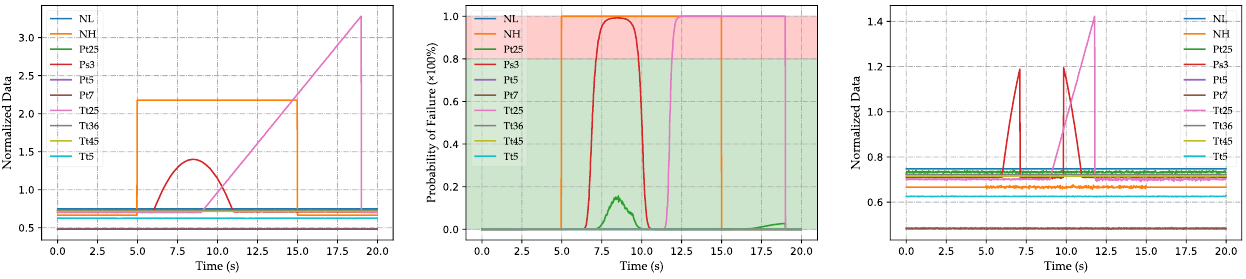
Figure 15. Validation of the FDI process with simultaneous multi-sensor failures in steady state.